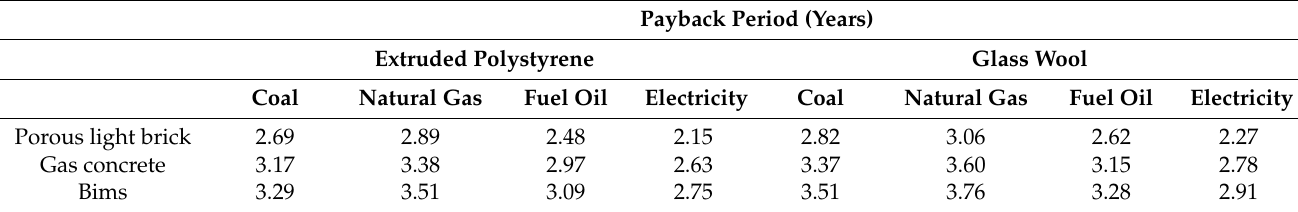
Table 7. Payback duration depending on fuel and insulating materials for wall